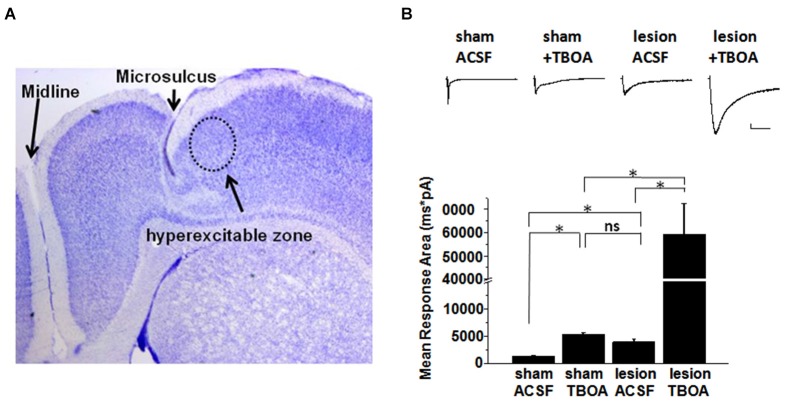
Synaptic responses in pyramidal cells in slices from sham and lesioned animals. (A) Representative image of a cresyl-violet stained slice from a lesioned animal showing the microsulcus. Dotted circle indicates the hyperexcitable zone. (B) Sample traces of evoked synaptic responses from a sham operated and lesioned animal. Responses obtained in (top: left to right) sham ACSF, sham after TBOA (30 µM) application, lesion neuron in ACSF and lesion neuron after TBOA (30 µM) application are shown. Bar graphs show quantification of the synaptic current response area following stimulation in sham and lesioned slices before and after TBOA application. Scale bar represents 200 pA and 500 mS.